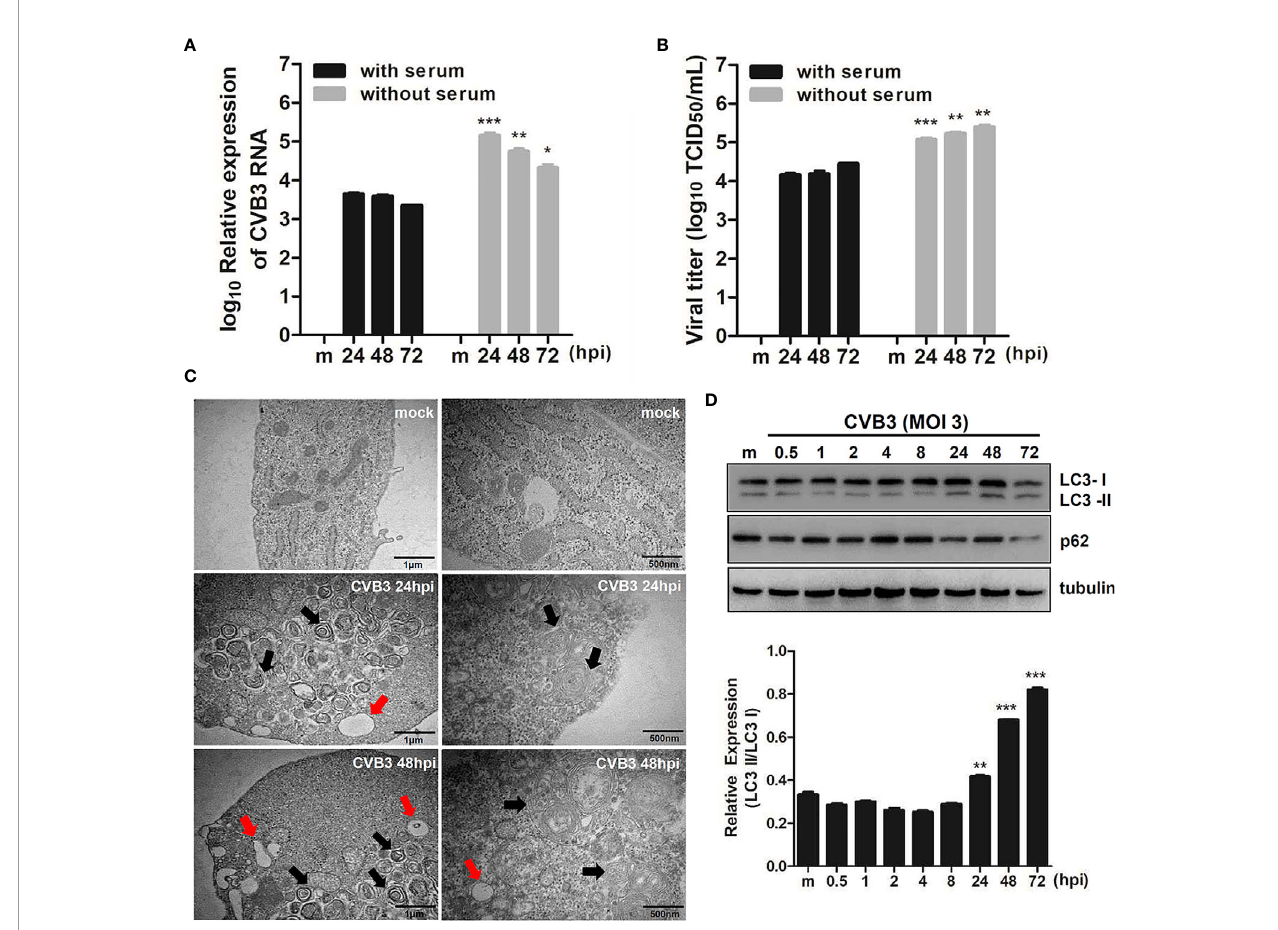
FIGURE 1 | CVB3 infection in hNPCs results in the induction of autophagy. (A) hNPCs (with or without serum starvation) were infected with mock or CVB3 at an MOI of 5 for the indicated time points. Quantitative realtime PCR was performed to measure CVB3 RNA copy number. Data are representative of three independent experiments (mean ± SD). (B) Supernatant was collected to determine viral titers measured by TCID50 assay. Results represent mean ± SD of two independent experiments. *p < 0.05; **p < 0.01; ***p < 0.001 vs . CVB3-infected cells cultured with serum. (C) The ultrastructure of intracellular organelles in CVB3-infected cells exposed to serum starvation was observed by transmission electron microscopy. Red arrow indicates lysosomes, and black arrow indicates autophagosomes. (D) Immunoblot analysis of LC3 and p62 expression in CVB3-infected cells at the indicated time points. Tubulin expression was examined, which was used as a protein loading control. The ratio of LC3-II to LC3-I expression at the indicated time points after CVB3 infection is shown in the graph, and band intensity was quantitated by densitometric analysis using the ImageJ